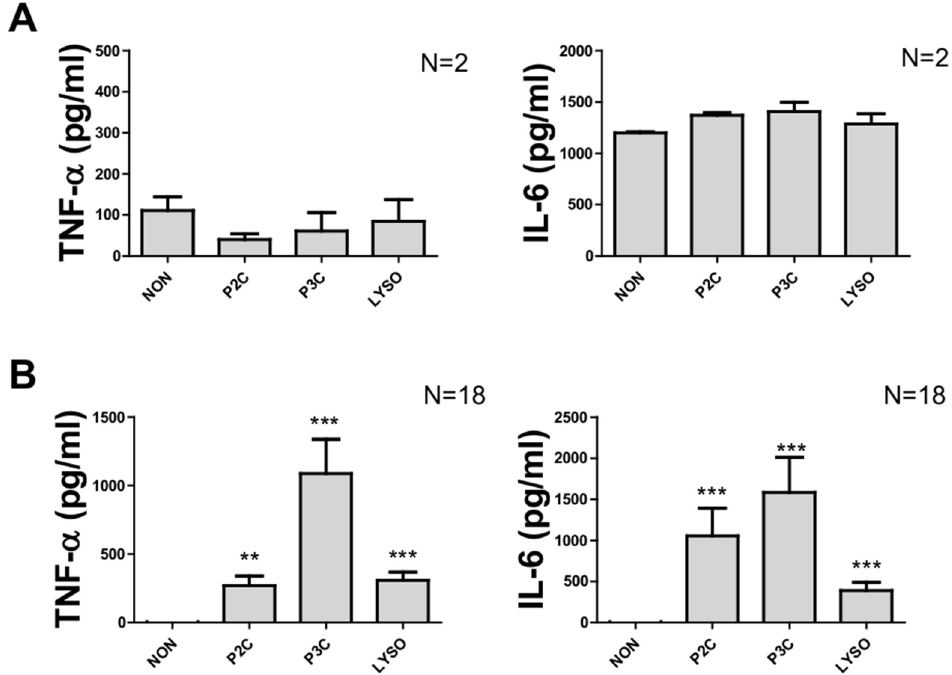
Figure 4. Cytokine production of CD14 + monocytes with resting. After 24 h resting in RPMI medium in normal cell culture plate ( A ) or in repellent surface plate ( B ), the monocytes were harvested and resuspended in a fresh RPMI medium at the concentration of 10 6 cells/mL. The 10 5 cells were stimulated with 100 ng/mL of P2C, P3C, or Lyso. The control samples (non) were used without adding any stimulators. TNF values were measured by ELISA from supernatant of 5 h stimulation, and IL6 and IL-10 were measured by ELISA from supernatant of 18 h stimulation. Samples from 2 donors ( A ) and 18 donors ( B ) were analysed in triplicate. Error bars represent the SEM. Statistical significances were calculated between the treated cells compared to control (non) by using Kruskal–Wallis test: ** p < 0.01, *** p < 0.001.